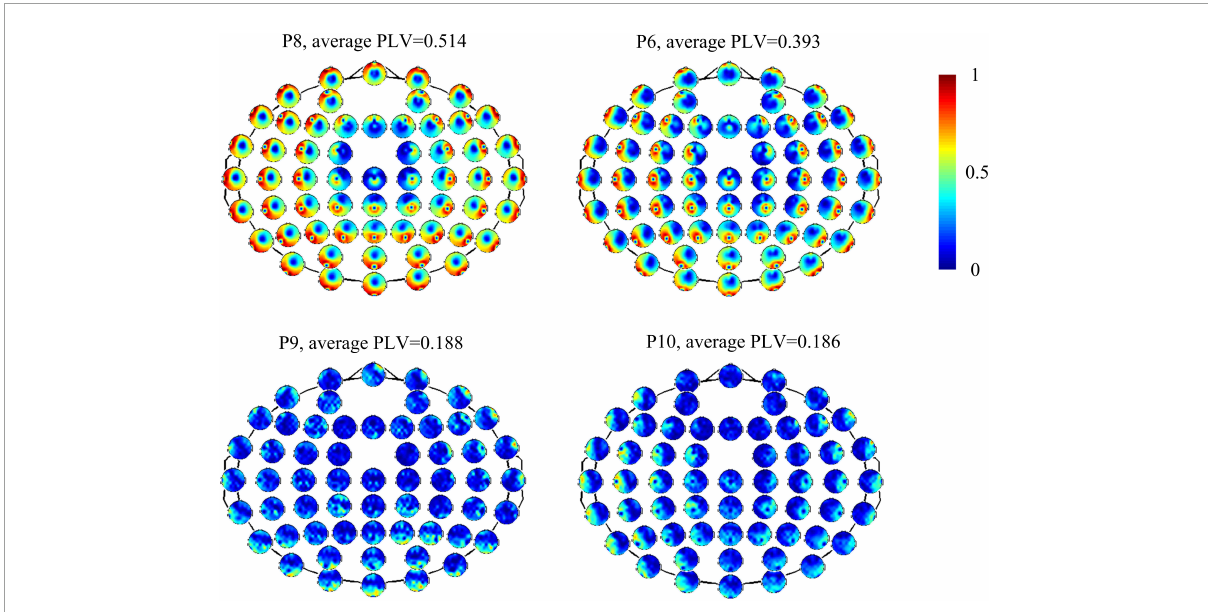
FIGURE1 Functional connectivity measured by PLV of electrodes with overall brain in four patients (P8, P6, P9, and